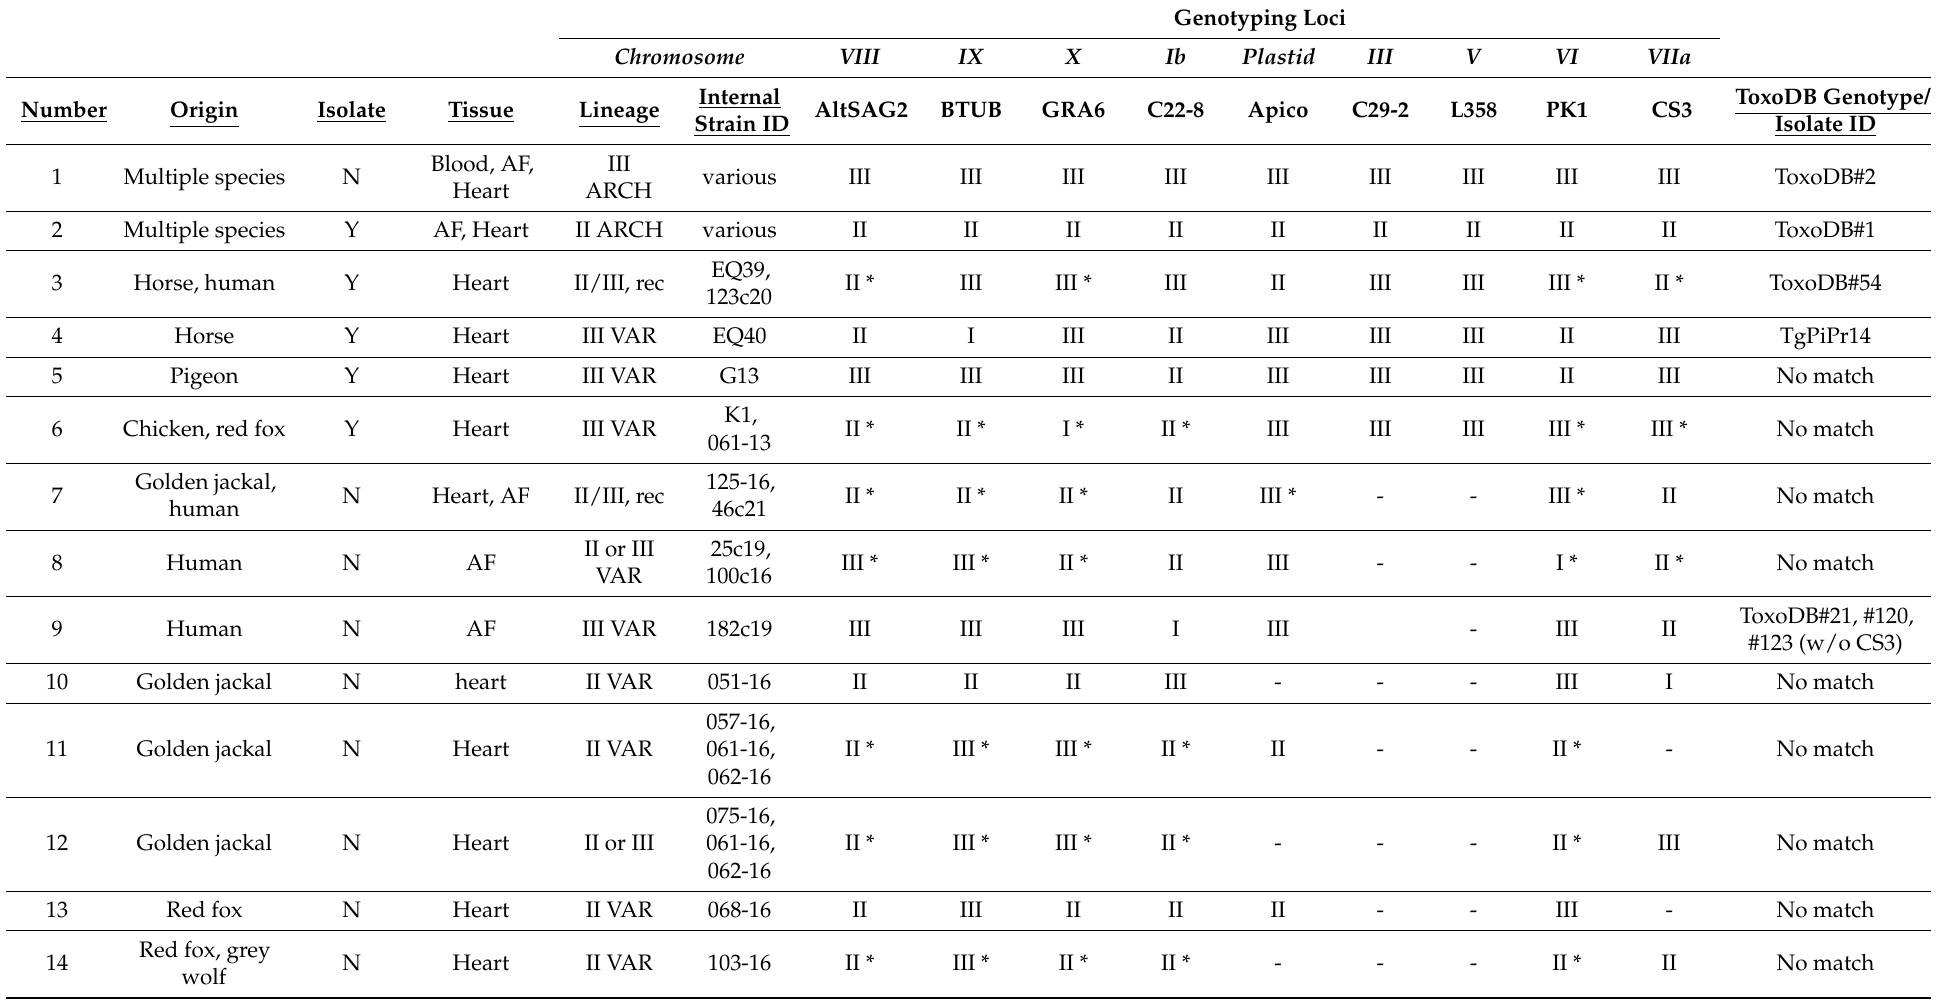
Table 1. Distinct T. gondii genotypes detected and/or isolated in intermediate hosts from